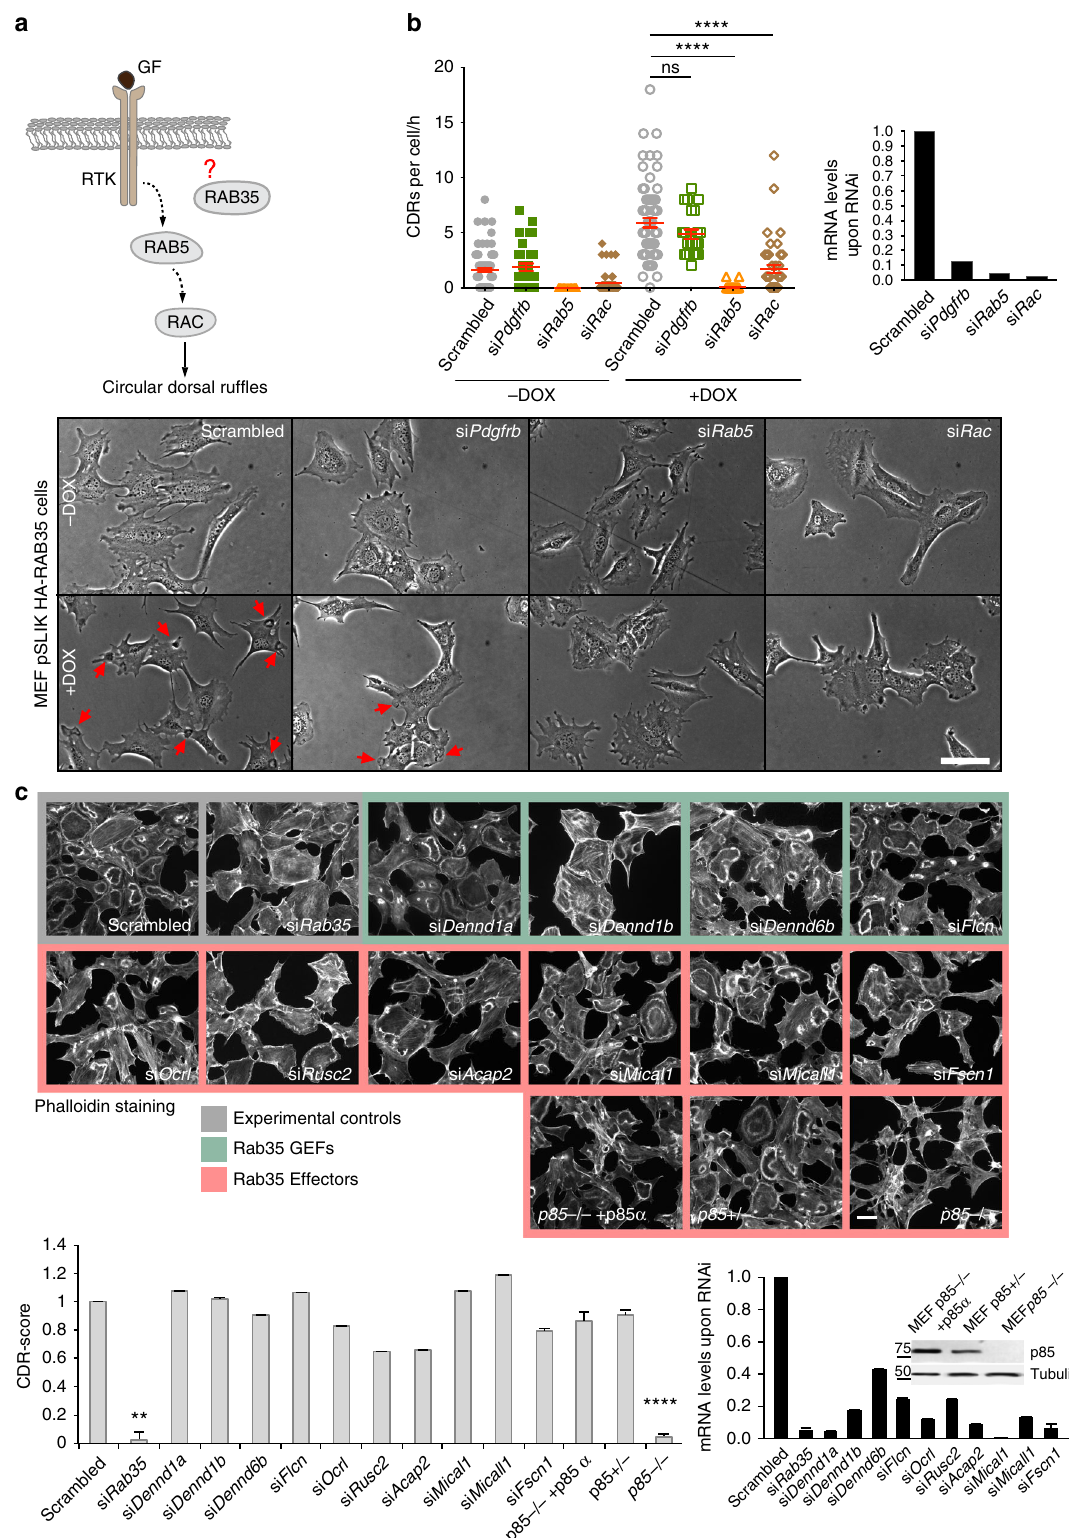
computed the average value of all cells in the image as the fi nal readout ( “ CDR_PerImage_RawScore ” ).